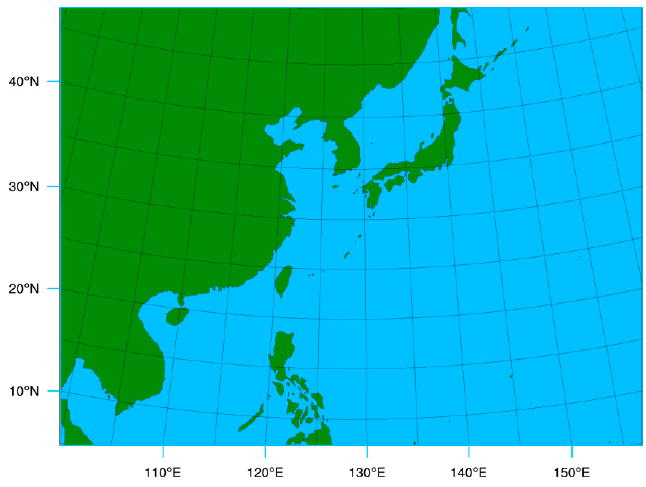
Figure 2. The simulation domain of WRF model.